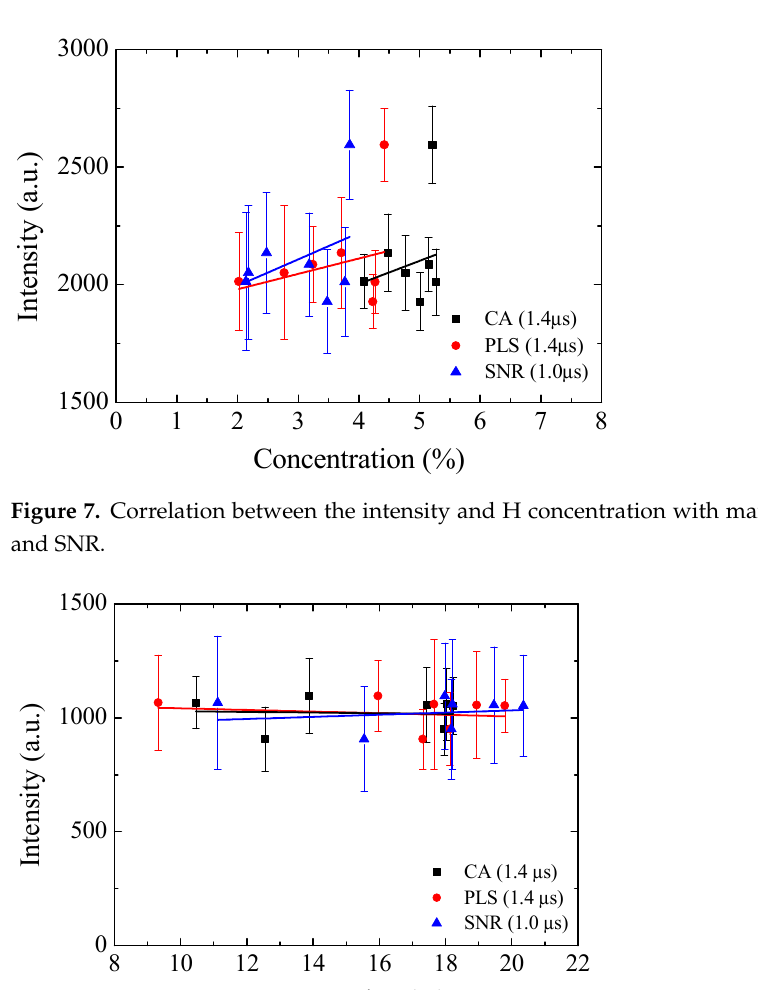
Figure 8. Correlation between the intensity and O concentration with maximum R 2 for CA, PLS, and SNR methods.